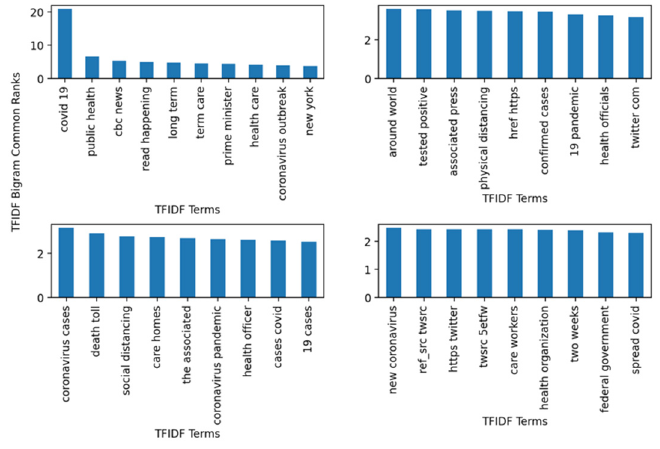
Figure 2. Shows the TF-IDF analysis of top-40 terms in four subfigures. Each figure contains 10 bigrams and their corresponding score.